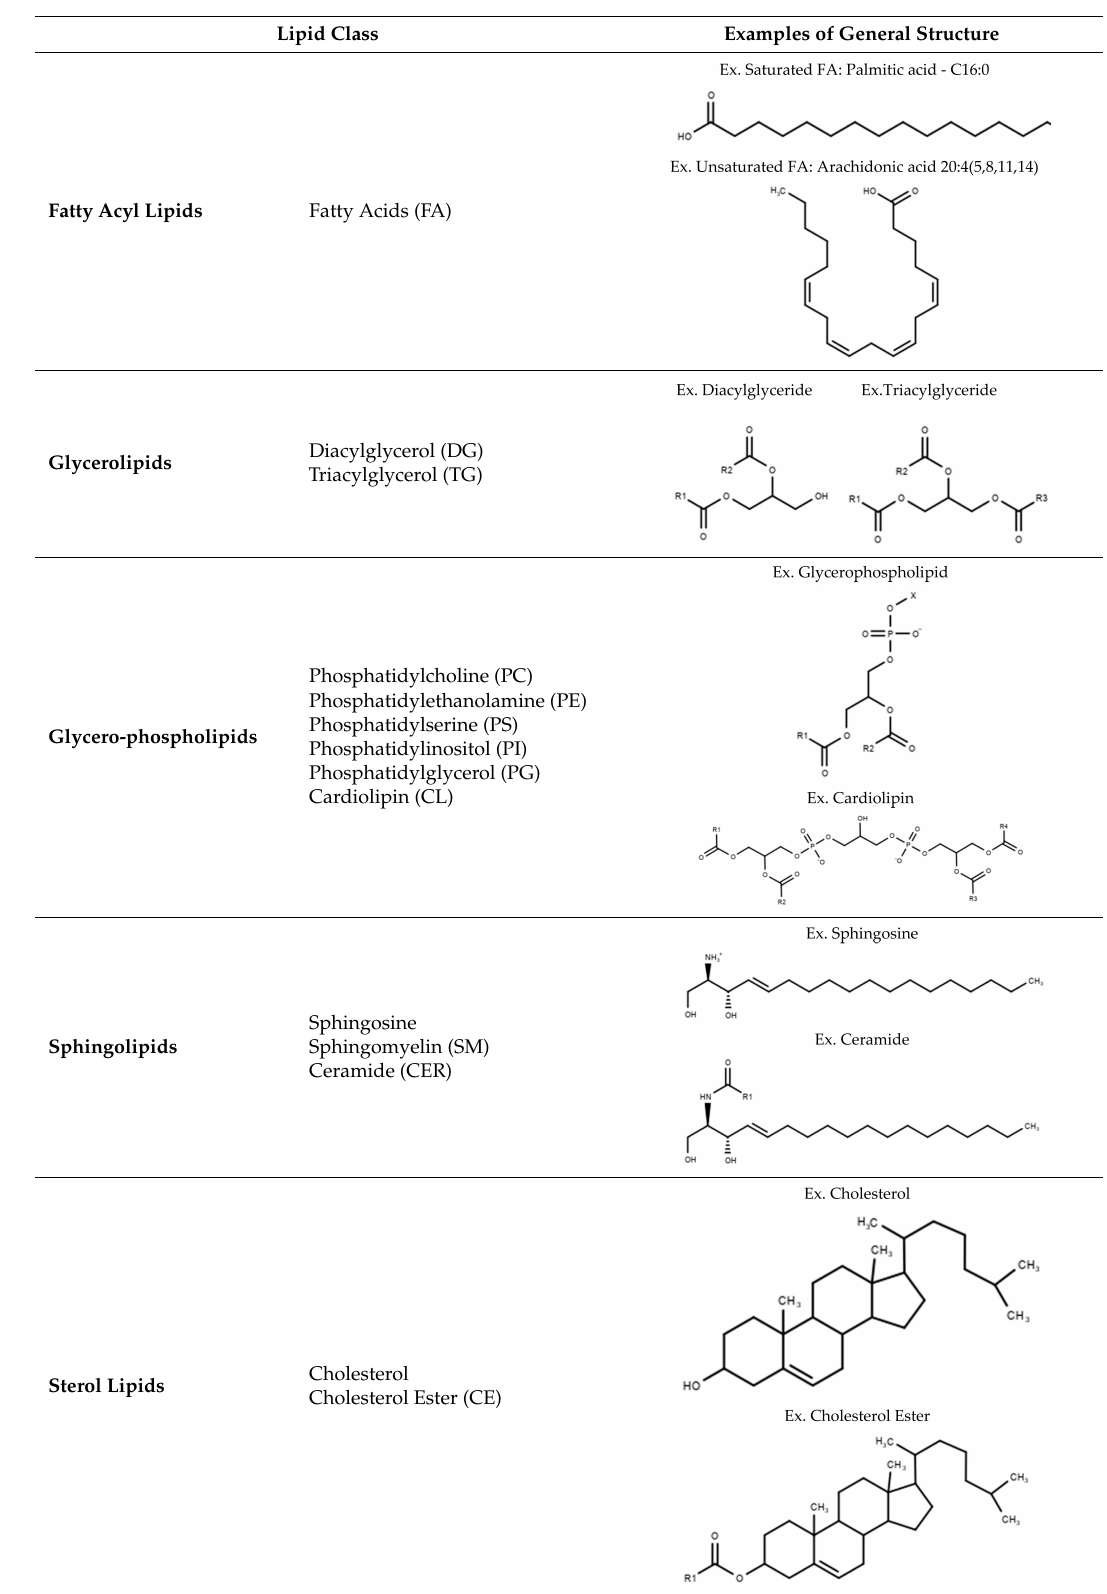
Table 1. Lipid Classes and Examples of General Structures.